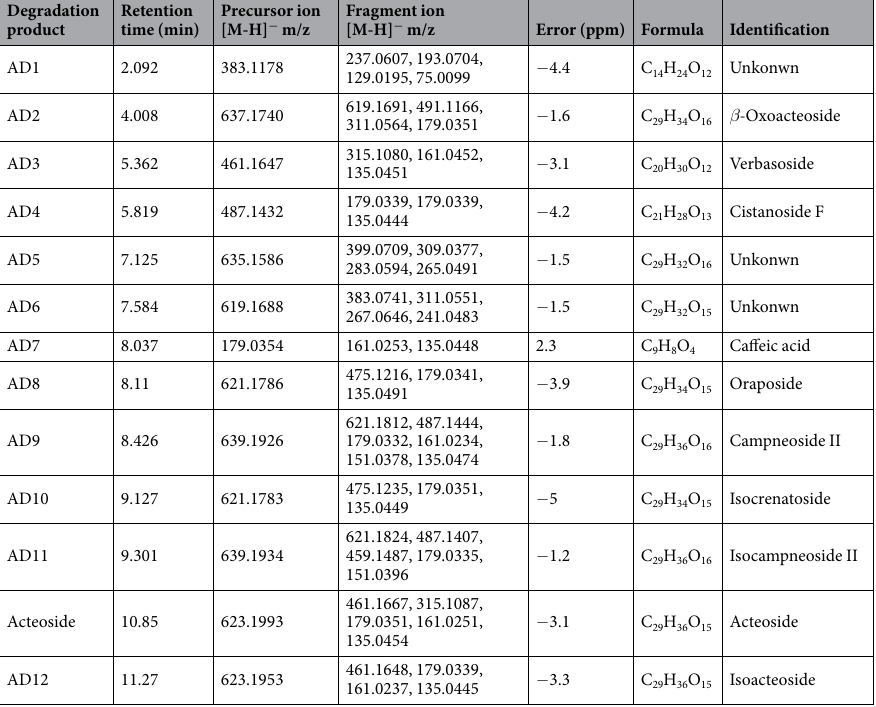
Table 2. Retention time, mass measurements, and predicted formulas of acteoside and its degradation products. AD, acteoside degradation products.